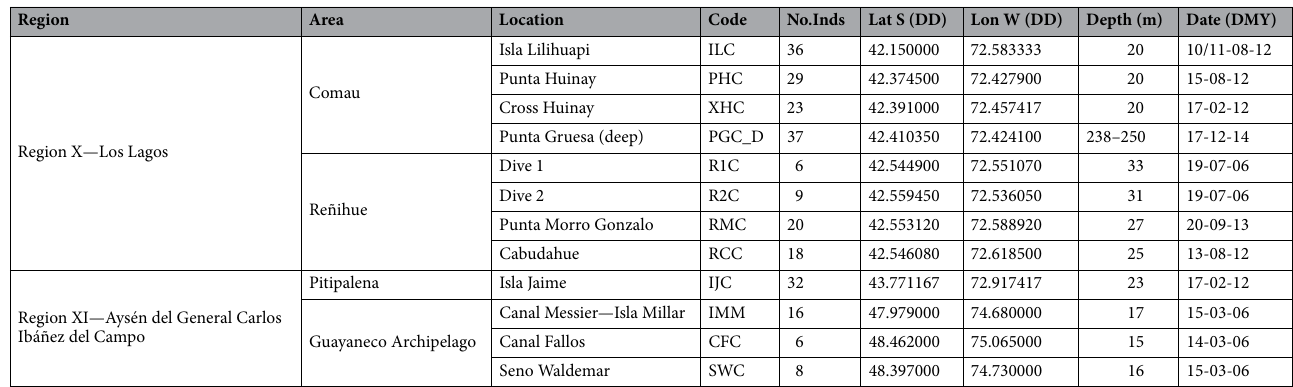
Table 1. Location and information on coral samples collected in Chilean Patagonia. No.Inds number of individuals analyzed, Lat S latitude South, Lon W longitude West, DD decimal degree, m meter, DMY day, month,